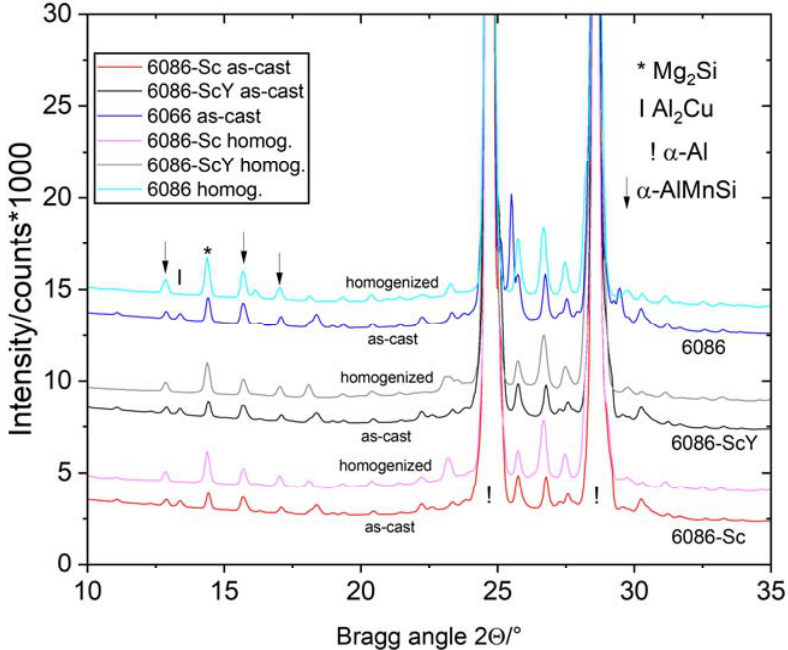
Figure 3. XRD patterns of the investigated alloys in the as-cast and homogenized conditions. The most important peaks of the identified phases are indicated.